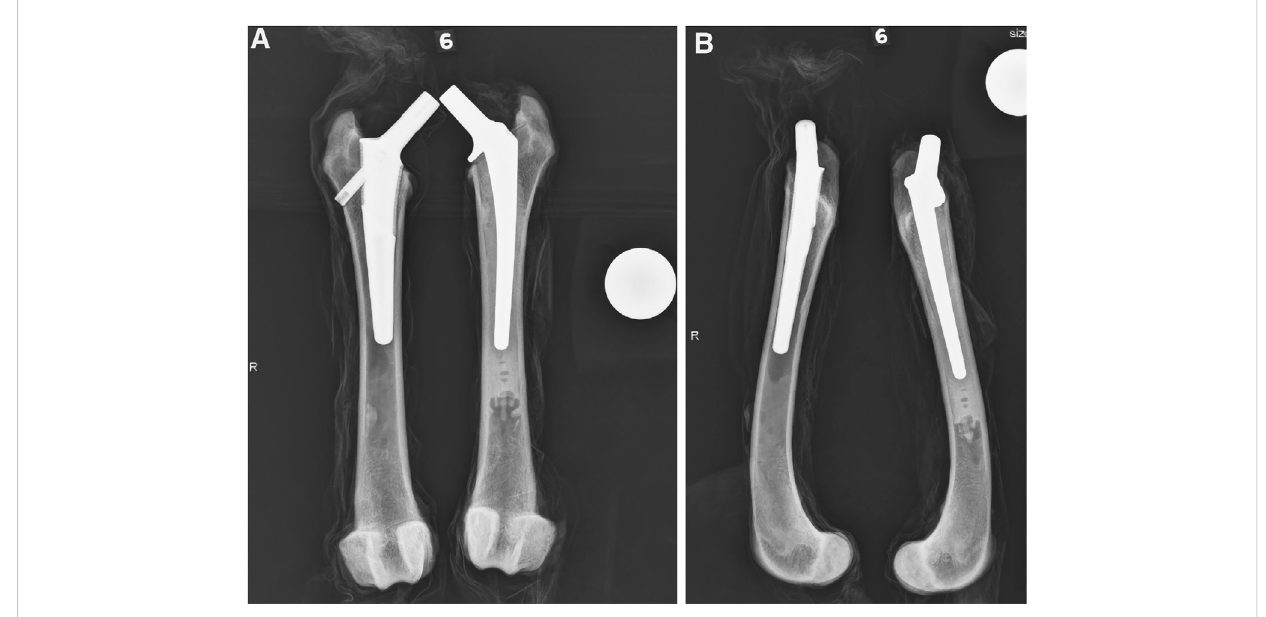
FIGURE 1 Representative cranial-caudal (A) and medial-lateral (B) radiographic views after stem implantation. The BFX + lb implanted femur is on the left and CFX implanted femur is on the